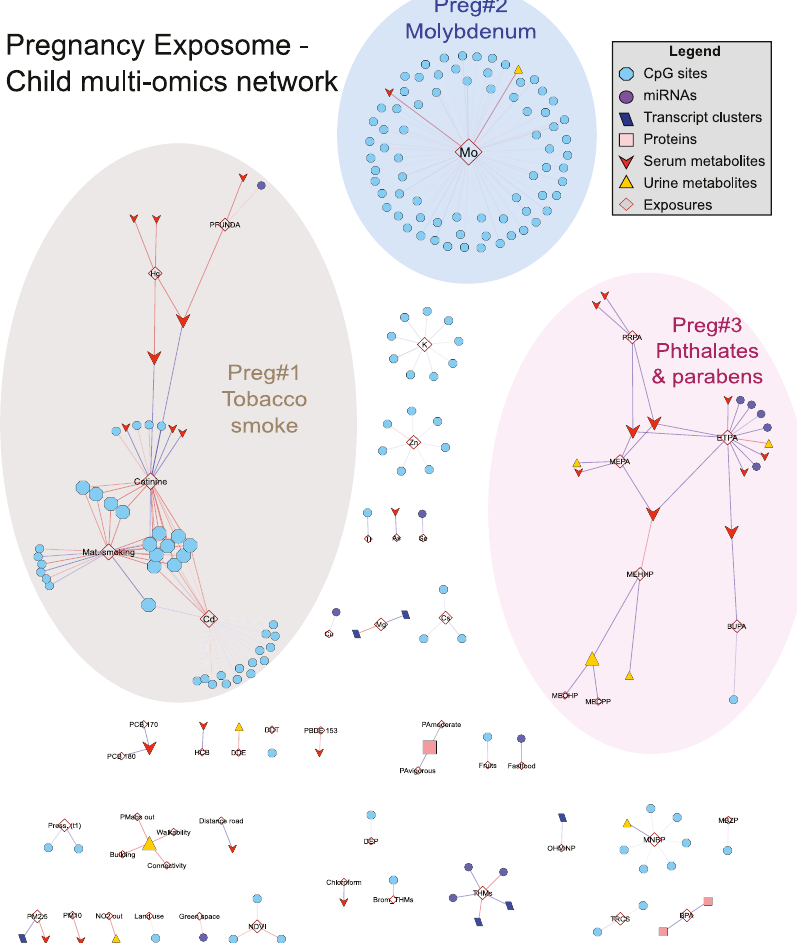
Fig. 4 | Network map of the multi-omics signatures of the pregnancy expo- some. Network visualization of the pregnancy exposome-omics-wide association study (ExWAS). An exposure and a molecular feature were connected if their associationwasstatisticallysigni fi cant(blueifpositivelyandredifnegatively).Only connectedcomponentswithatleasttwomolecularfeaturesweredisplayed.Nodes of the network are depicted with a different colour/shape depending if they are